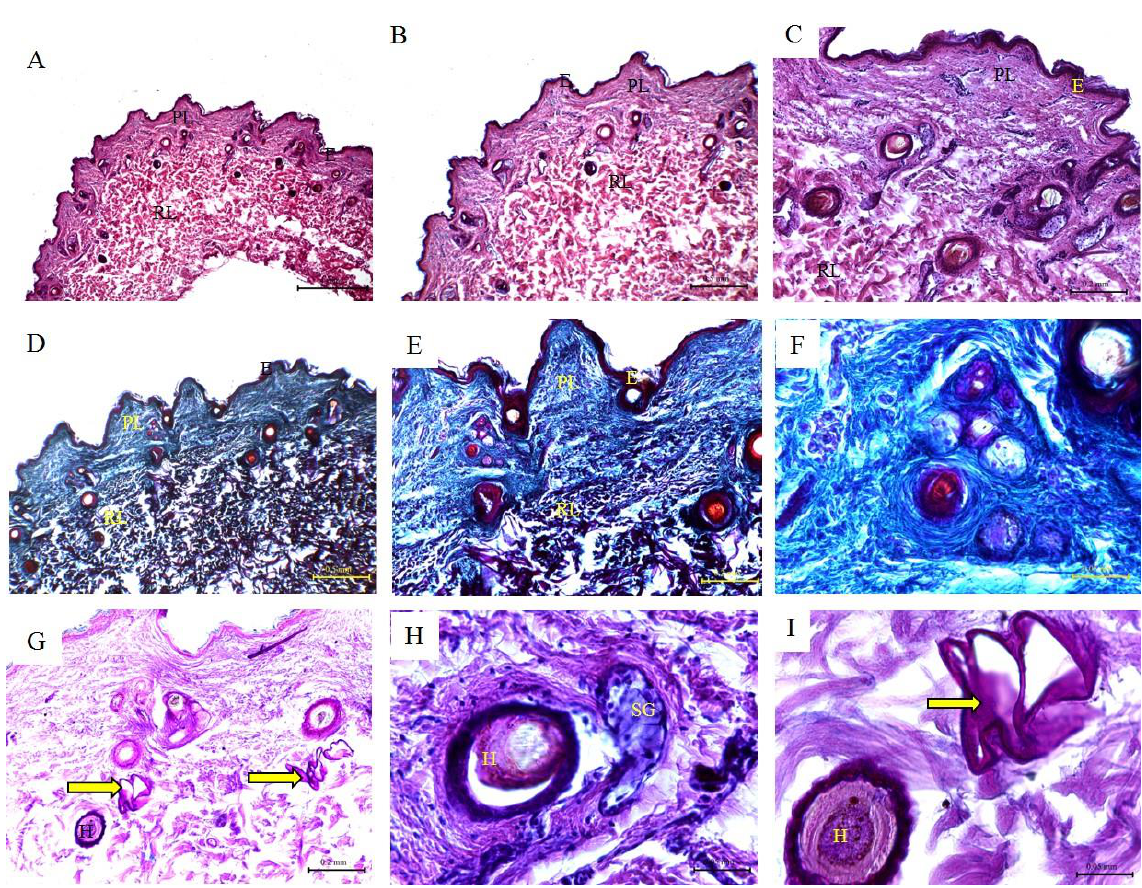
Figure 5: Histological features of goat skin. Hematoxylin and eosin staining ( A-C ; G-H) ; Crossman's trichrome staining ( D-F) ; and PAS staining ( I ) of goat skin tissue sections. (E) Keratinized stratified squamous epithelium of the epidermis; (PL) Papillary layer of the dermis; (RL) Reticular layer of the dermis; (NT) Nervous tissue; (SG) Sebaceous glands; (yellow arrow) Sweat